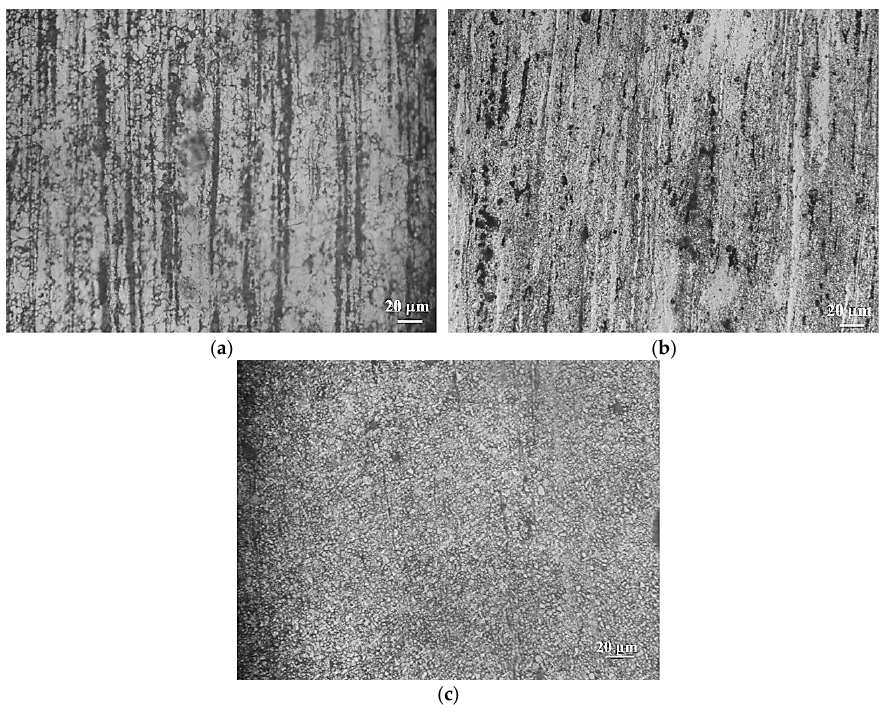
Figure 1. Microstructures of starting material prepared by DMD processing: ( a ) AZ31-1.5NAl composite, ( b ) AZ31-1Ca-1.5NAl composite, and ( c ) AZ31-2Ca-1.5NAl composite. The extrusion direction is vertical.